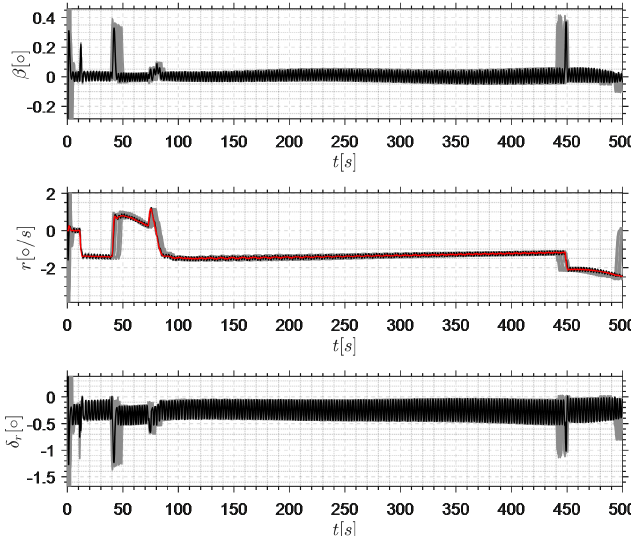
Figure 27. Perturbation simulation of yaw channel during flight mission.